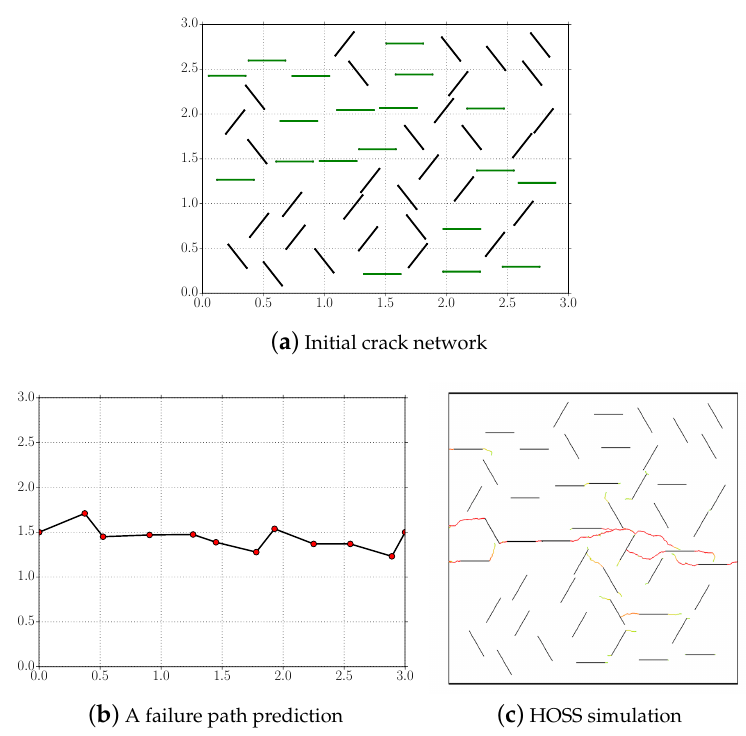
Figure 9. 50 crack problem: The above figures describe the application of the proposed method for estimating failure paths for 50 crack problem.